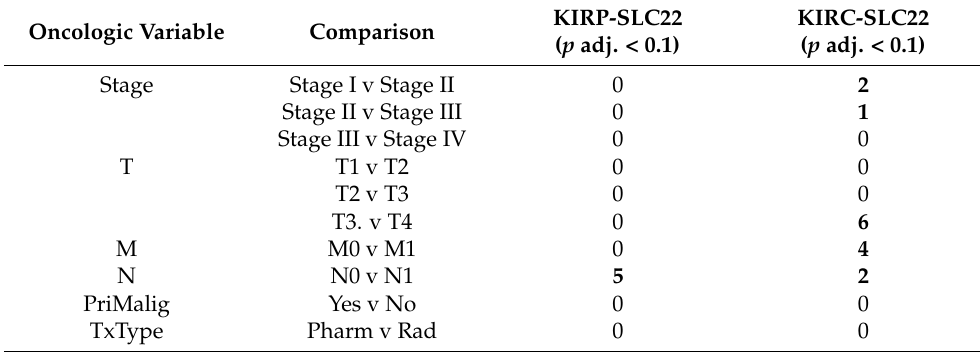
Table 3. Summary of pathologic variable DE analysis in KIRP and